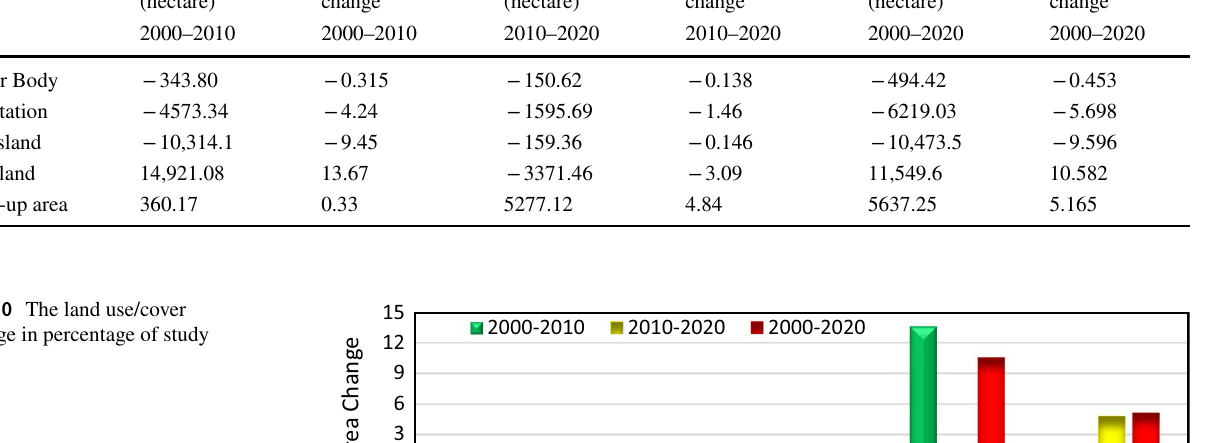
Table 7 Land use/cover changes detection from 2000–2020 Land use/cover type